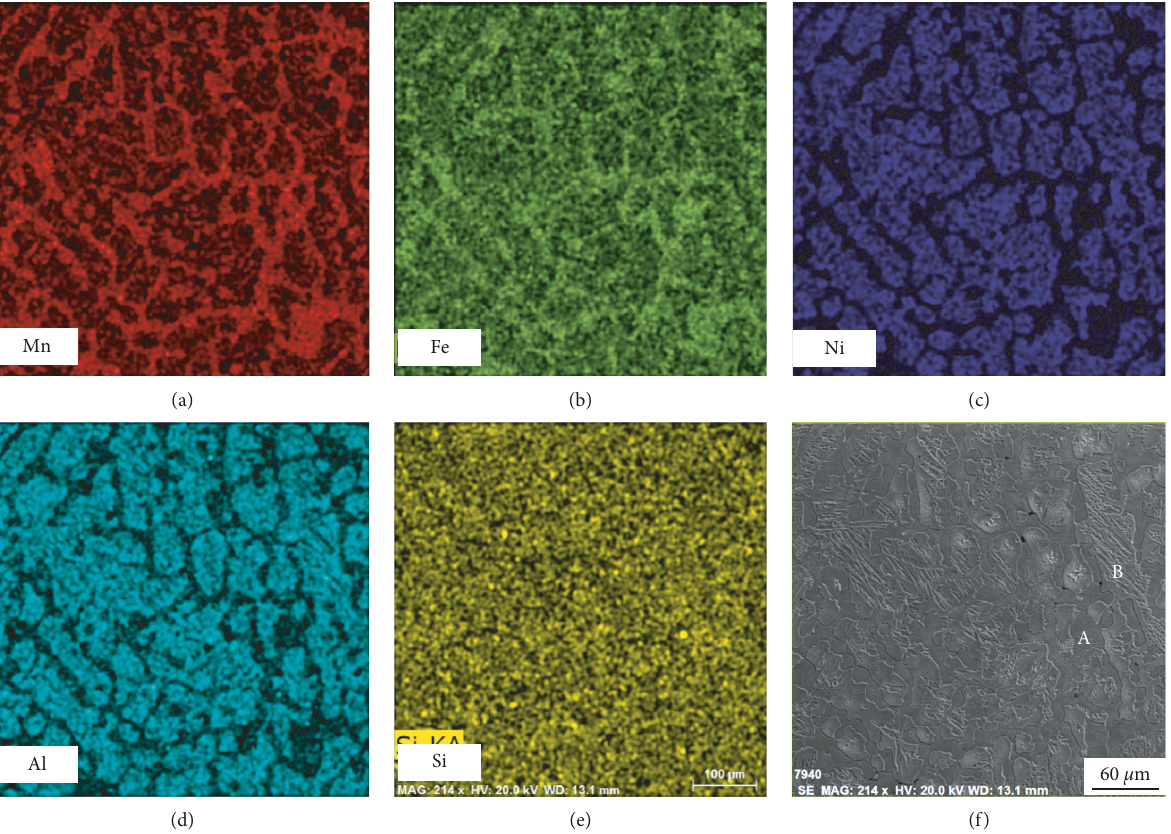
Figure 4: Elemental maps performed by EDX on the as-cast sample with 0.0%